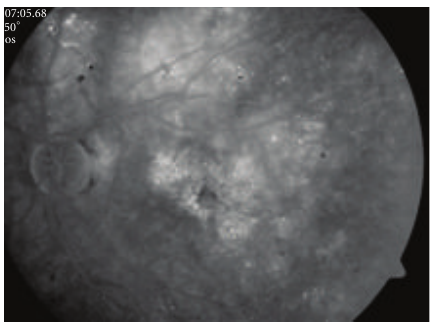
Figure 2: Late phase of fluorescence angiography shows macular leakage with a petalloid pattern. Note multiple microaneurysms and di ff use hyperfluorescence superotemporal to optic